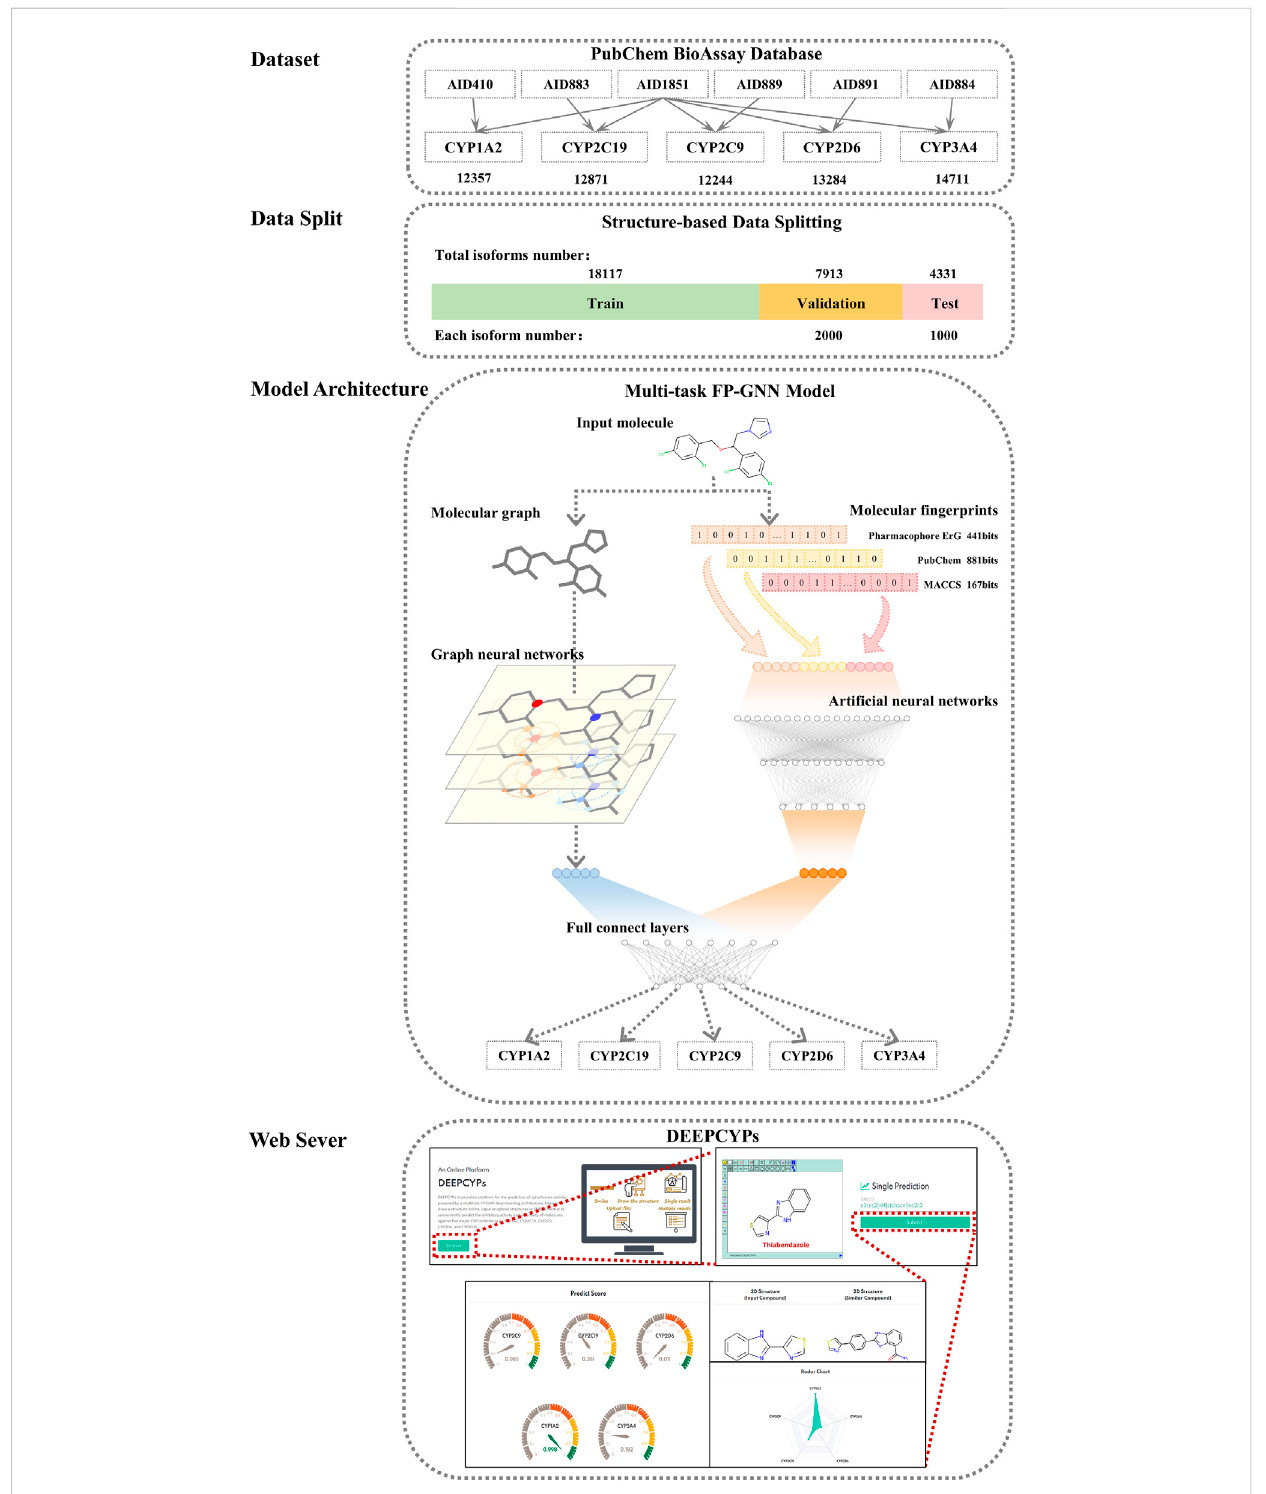
FIGURE 1 Model construction